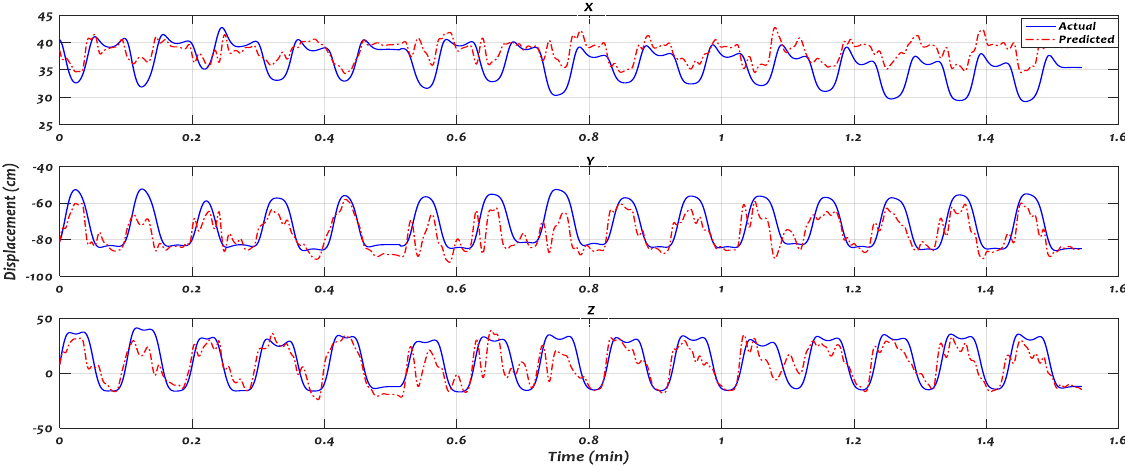
Figure 13. Prediction time horizons and their associated performance.